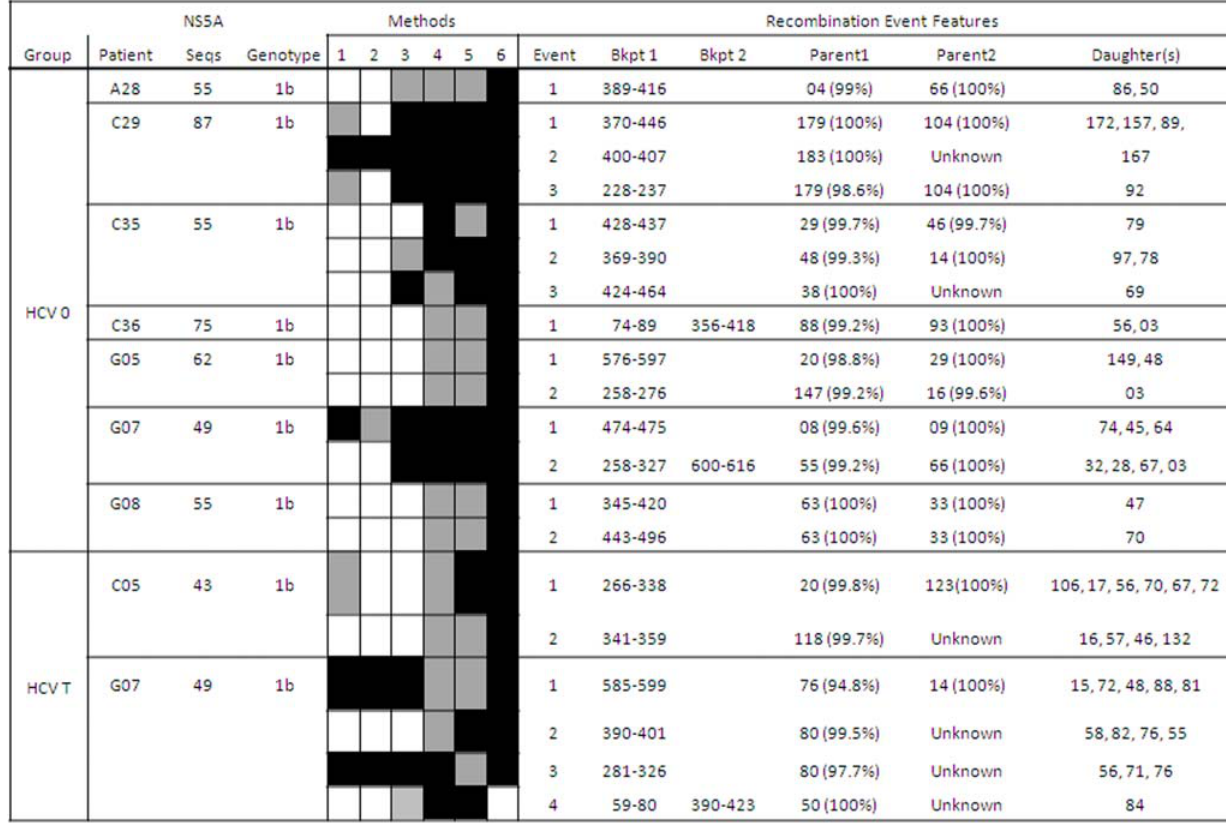
Figure 3. Summary of positive recombination results in the NS5A region. See further details in legend to Figure 1.